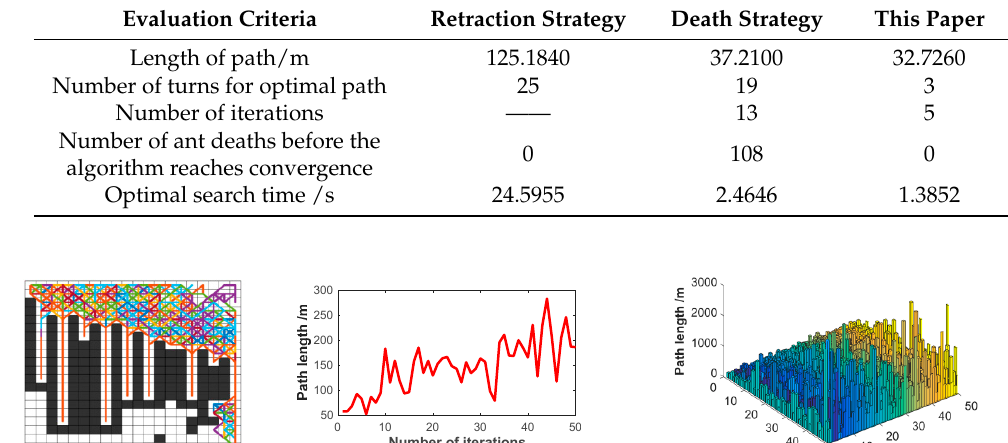
Table 3. Performance comparison table of algorithms for deadlock environment.